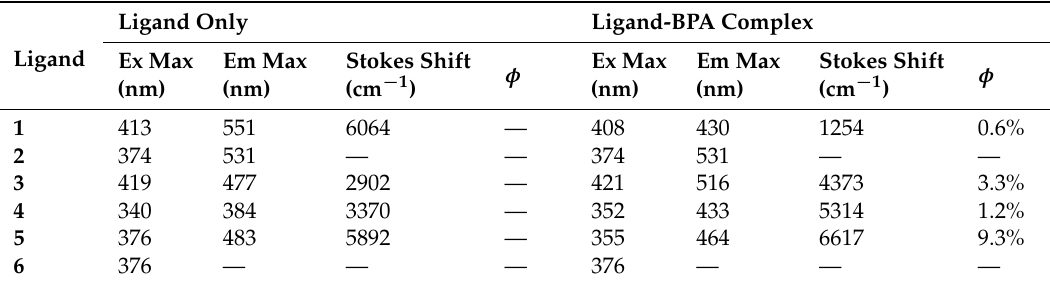
Figure 3. Candidate compounds for the fluorescent boron sensor. Table 1. Fluorescence properties of the various ligands and ligand-BPA complexes [a] .